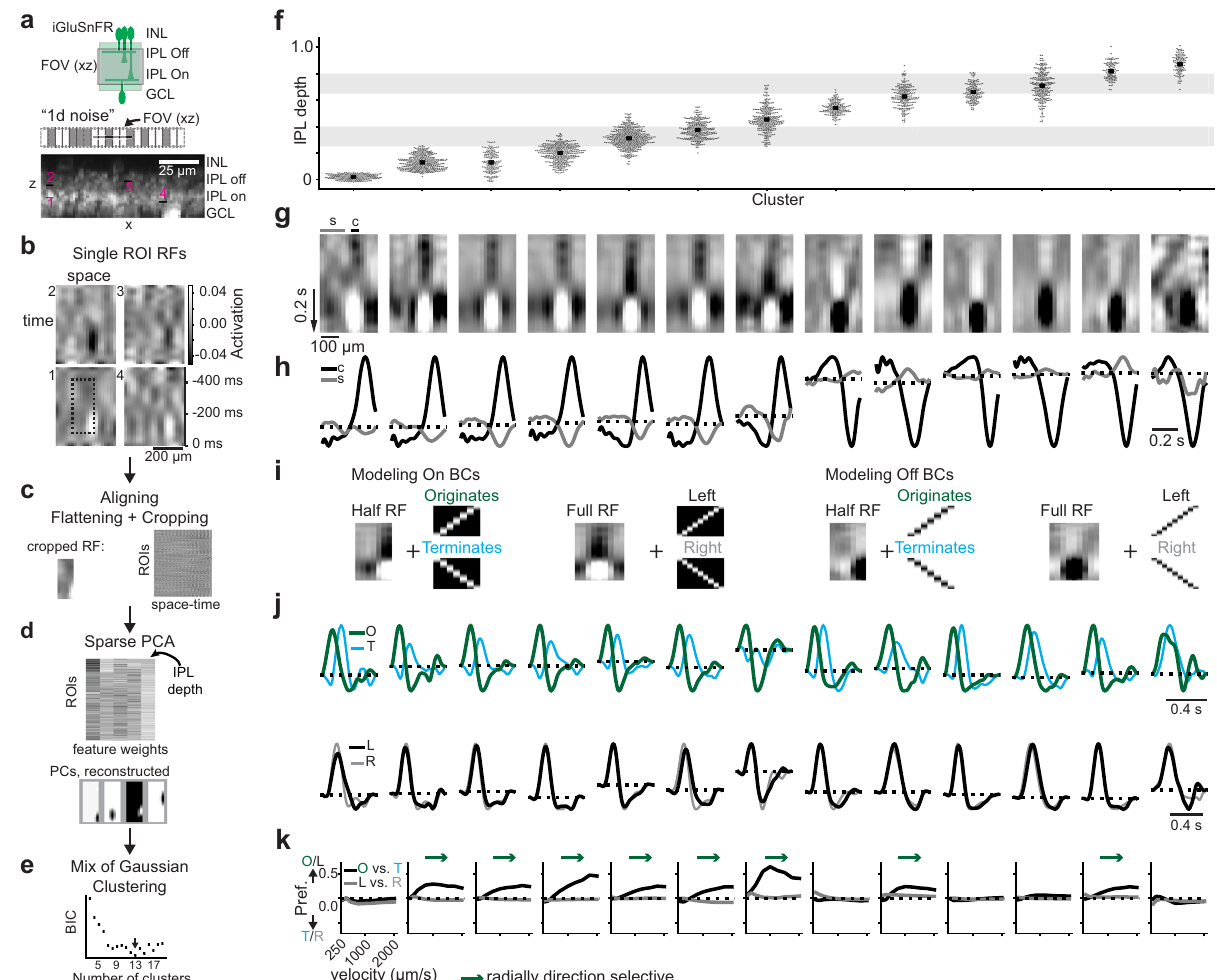
Fig.2|Bipolarcellreceptive fi eldsexhibitdifferingradialdirectionselectivity. a Top: iGluSnFR is ubiquitously expressed in the IPL, which was vertically scanned using an electrically-tunable lens. Middle: “ 1D noise ” stimulus consisting of twenty 20×50 μ m rectangles switching randomly between black and white at 20Hz. The relative scale of the FOV is shown. Bottom: average of a scan with exampleregions of interest (ROIs, black regions in b ). b Example RFs from the ROIs in ( a ). Dotted box:thecroppedRFusedforclustering. c Top:thecroppedRFfromthedottedbox in( b ),withthesameaspectratioastheprincipalcomponents(PCs)in( d ).Bottom: RFswerealignedtotheRFcenterandthenallRFswere fl attenedto1dimensionand croppedto excludemissing space-time. Sample sizeis3,233 ROIs/ 4 fi elds/3 mice. d Top:featureweightsforthe4componentsfromPCA.The fi fthfeaturewastheIPL depthoftheROI.Bottom,reconstructed componentsof thesparsePCA. e Mixture of Gaussianclustering wasperformed and the Bayesianinformation criterion (BIC)